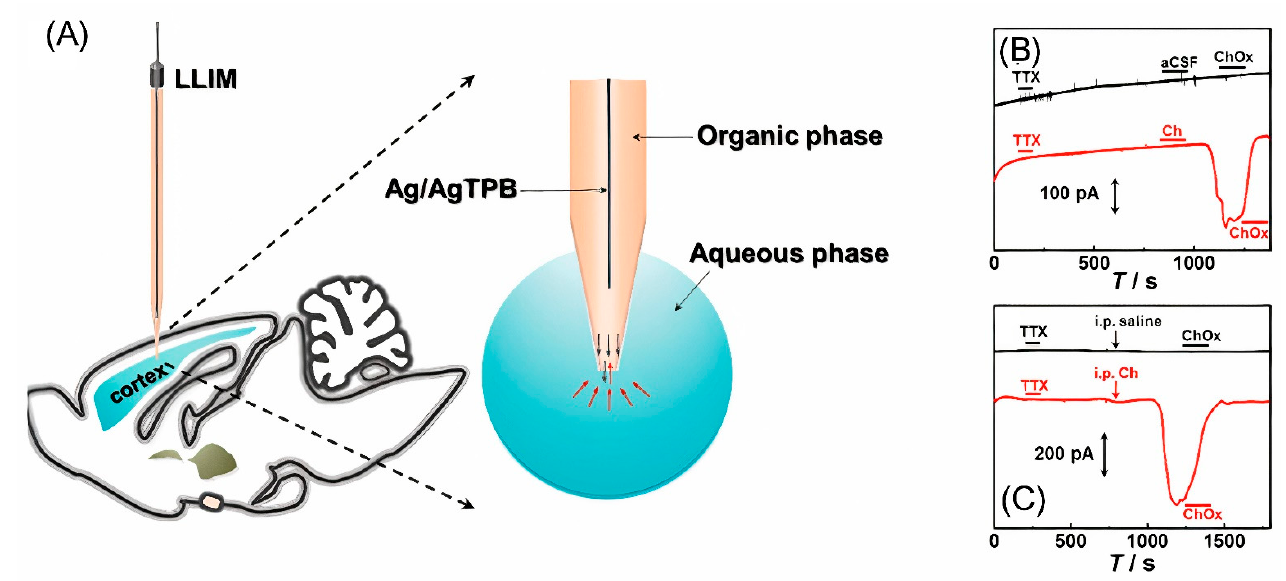
Figure 5. ( A ) Illustration of the liquid/liquid interface microsensor used in measurement of typical amperometric responses in the brain cortex of anesthetized rats during local microinfusion with ( B ) 100 ppm tetrodotoxin, pure aCSF and 1kU/L choline oxidase (ChOx) (black curve) and 100 ppm tetrodotoxin, aCSF containing 10 mM Ch and 1 kU/L ChOx (red curve), and ( C ) 100 ppm tetrodotoxin and intraperitoneal injection with 0.9% saline (black curve) or 334.8 mg/kg choline (red curve) and local microinfusion with 1 kU/L ChOx as labeled in the figure. Reproduced from [77], copyright 2021 American Chemical